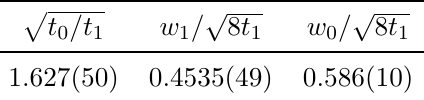
t t 1 . Scales 1 ( 0 ) and s = 0 . 05(0 . 1)